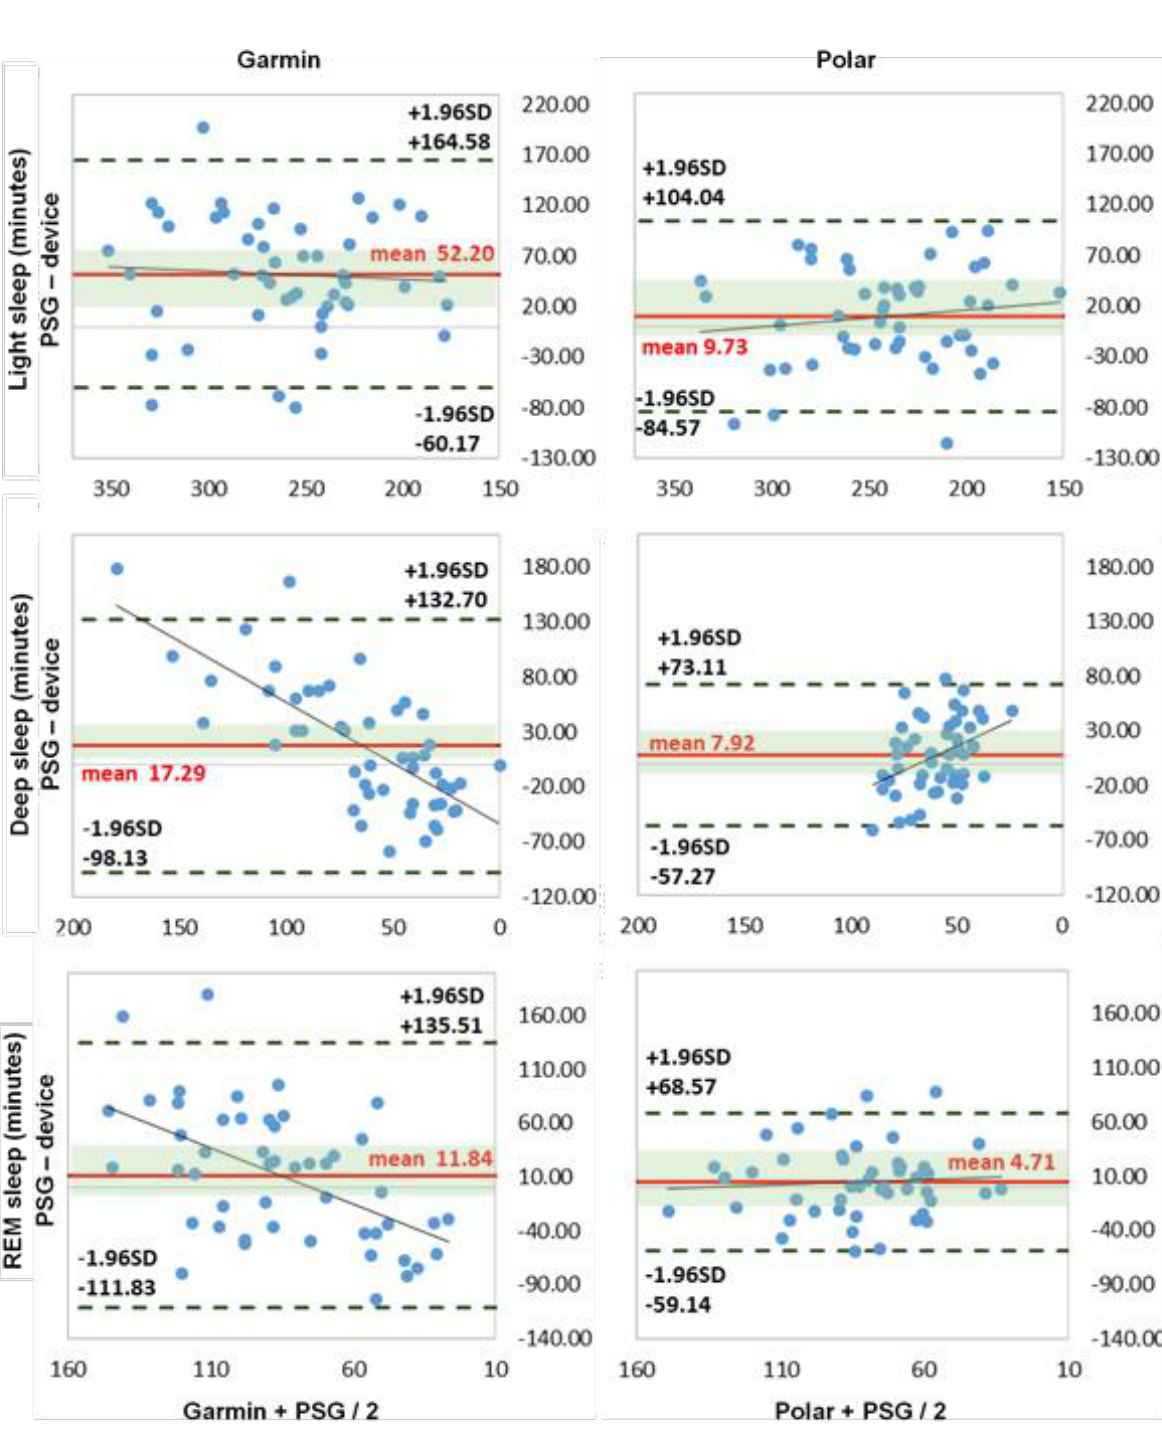
Figure 3. Bland–Altman plots of sleep stages ( n = 49). NREM, light sleep (NREM1 + NREM2), deep sleep (SWS, NREM3) and REM sleep = rapid eye movement sleep (all expressed in minutes). x -axis represents the mean values of the device and PSG; y -axis represents the differences between the PSG and the device; dashed black line represents the upper and lower limit of agreement (mean +/ − 1.96 SD); solid red line represents the mean value of difference; solid blue line represents the trend line; shaded green area represents 95% CI (confidence interval) of mean difference.